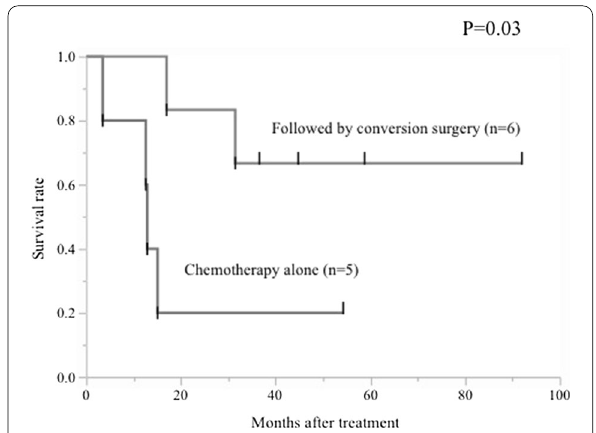
Fig. 3 Kaplan–Meier analysis demonstrated that patients who received conversion surgery showed significantly better overall survival than those without conversion surgery (chemotherapy alone) ( P =